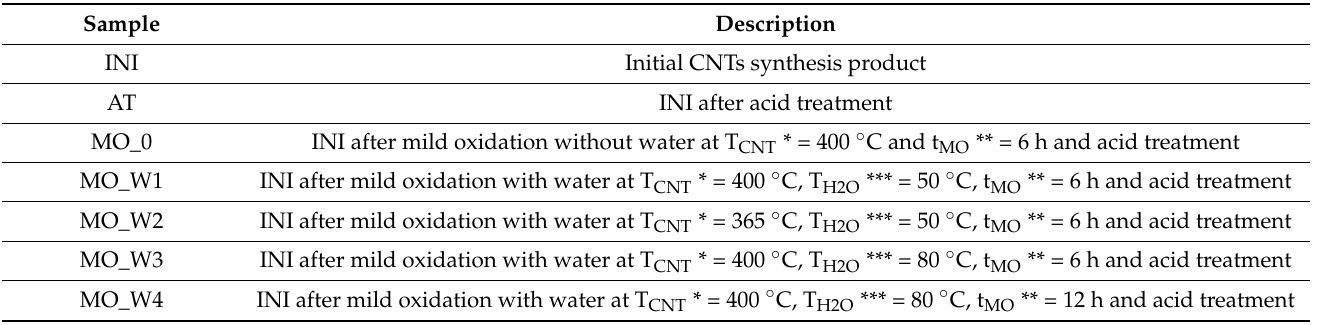
Table 1. Marking of samples and conditions of their treatment.